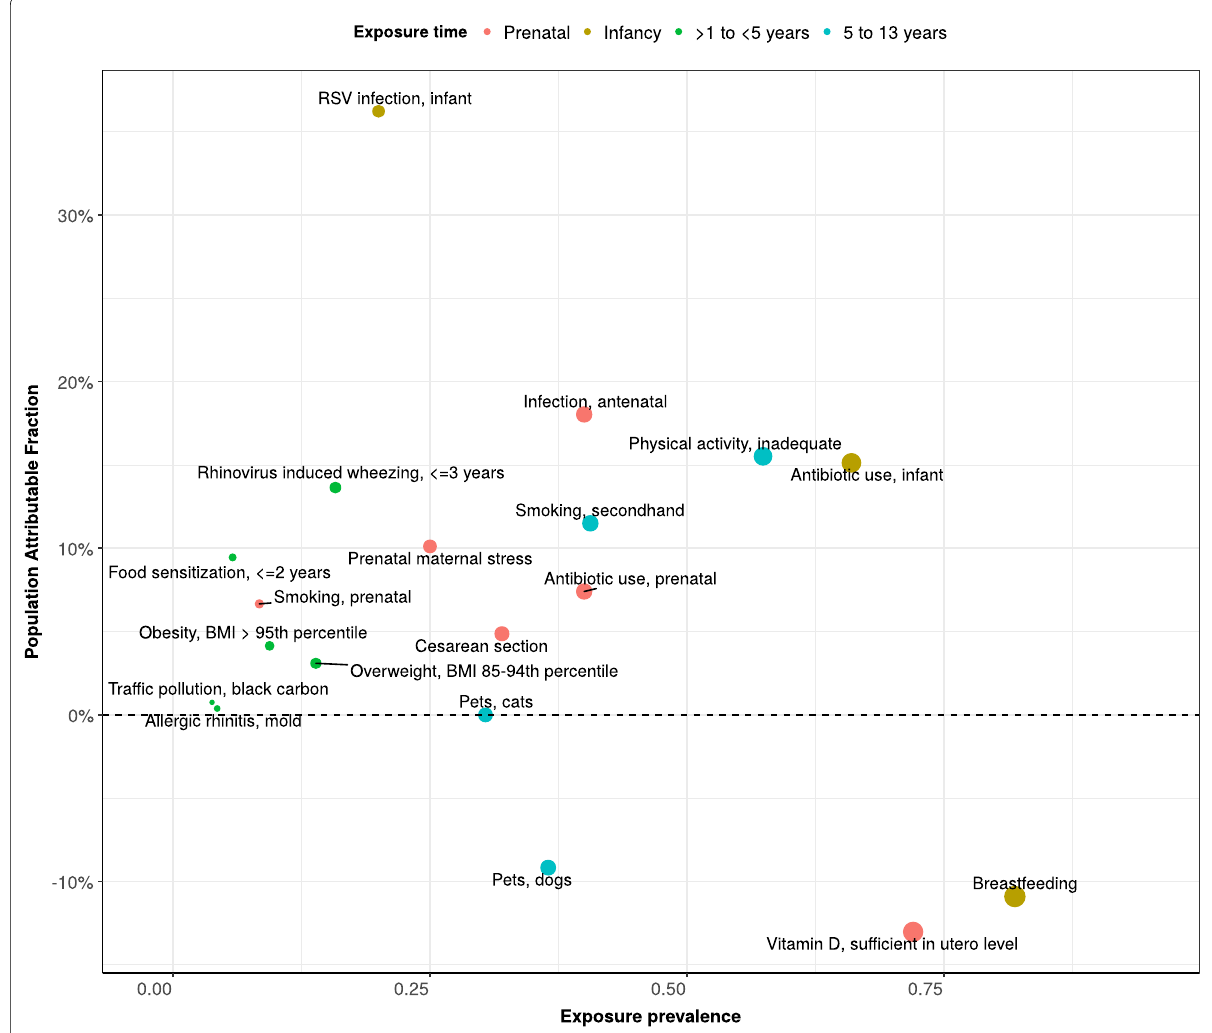
Fig. 2 Population attributable fraction (PAF) among selected risk factors. PAF, the proportion of cases that are attributable to a risk factor and could be prevented by modifying or eliminating the risk factor, is shown on the y-axis. The x-axis represents the risk factor exposure prevalence. The points on the graph reflect the relationship of exposure prevalence and PAF. The PAF is dependent on the prevalence of exposure and its odds ratio for asthma. The size of the points are proportional to prevalence. Odds ratios from meta-analyses were used to estimate PAF (Additional file 1: Table S1 and Fig. 1). References used to determine exposure prevalence for this figure: smoking, secondhand [71]; gas stove cooking [109]; physical activity, inadequate [110]; pets, cats [111]; probiotics [112]; omega-3 fatty acids [112]; H. pylori [113]; pets, dogs [111]; food